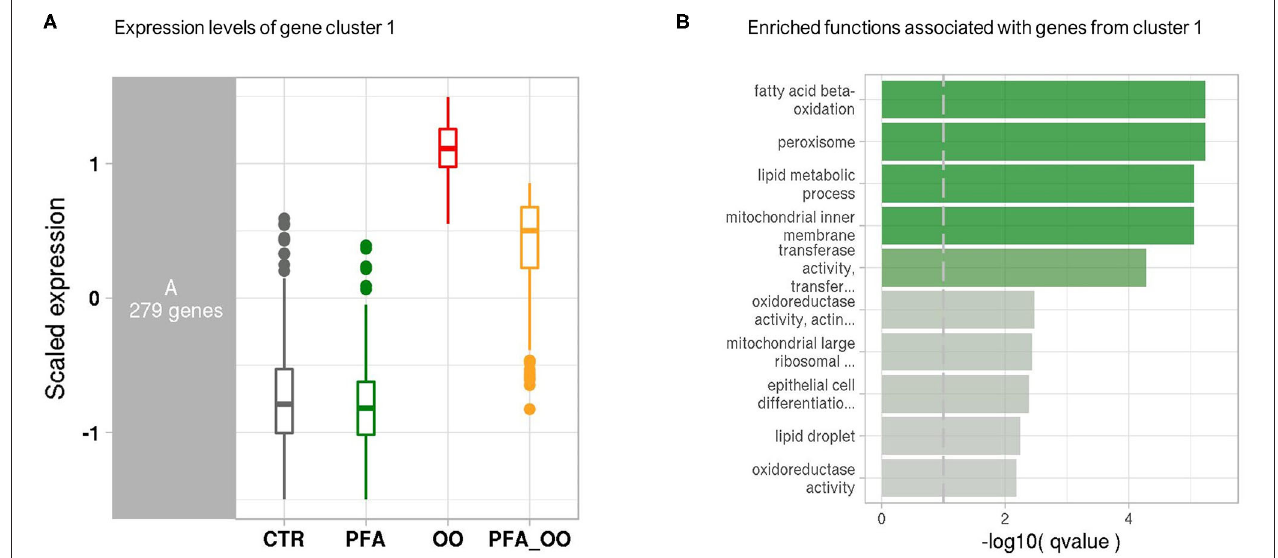
FIGURE 2 | Co-expression network modules and functions. (A) Boxplot of expression levels per condition of the gene cluster 1, exhibiting similar expression pattern. Control (CTR), Phytogenic Feed Additive (PFA), Oxidized Oil (OO), and Oxidized Oil + Phytogenic Feed Additive (PFA_OO). Expression values ( y -axis) are centered to the mean and scaled to the standard deviation for each gene. (B) Bar plot generated from the overrepresentation analysis and showing the top enriched functions associated with the genes from cluster 1. Bars are colored according to the negative logarithm of the hypergeometric test q -value (threshold set at